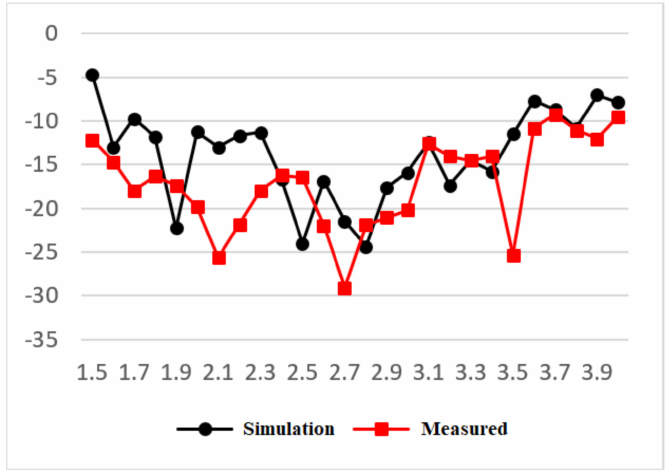
Figure 18. Receiving antenna simulation and measured S11